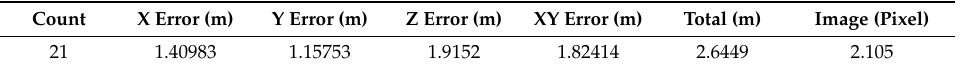
Table 2. The RMSE control